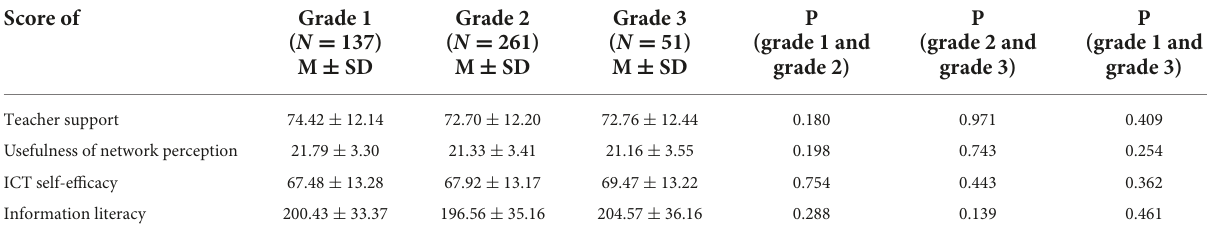
TABLE 1 Analysis results in grade